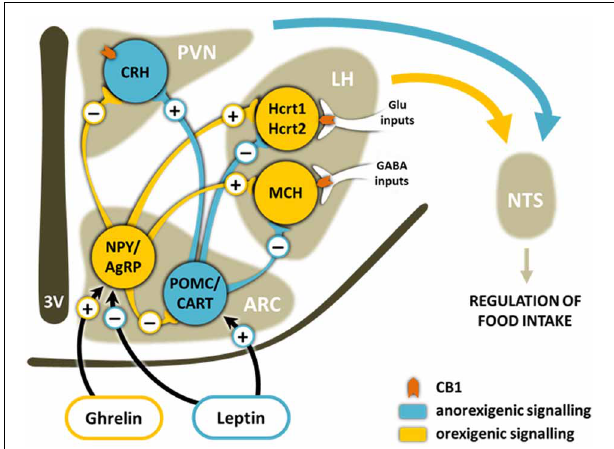
FIGURE 3 | Schematic representation of the main brain pathways involved in the homeostatic control of food intake. Ghrelin released during fasting from stomach and leptin from adipose tissue, among other mediators, bind to receptors on orexigenic and/or anorexigenic neurons in the ARC of the hypothalamus. This induces the release of either the orexigenic neuropeptides NPY and AgRP or the anorexigenic neuropeptides CART and the POMC-derived peptide α -MSH. These neuropeptides from the ARC travel along axons to secondary neurons in other areas of the hypothalamus such as the PVN and the LH. The ultimate effects of these signaling cascades are changes in the sensation of hunger and satiety in the NTS. Hypocretinergic and MCH neurons are modulated differently by inhibitory or excitatory CB1-expressing inputs. ARC, arcuate nucleus; PVN, paraventricular nucleus; LH, lateral hypothalamus; NTS, nucleus of the tractus solitarius; 3V, third ventricle; NPY, neuropeptide Y; AgRP, Agouti-related peptide; CART, cocaine- and amphetamine-regulated transcript; POMC, pro-opiomelanocortin; MCH, melanin-concentrating hormone; CRH, corticotropin-releasing hormone; Hcrt1, hypocretin-1; Hcrt2,